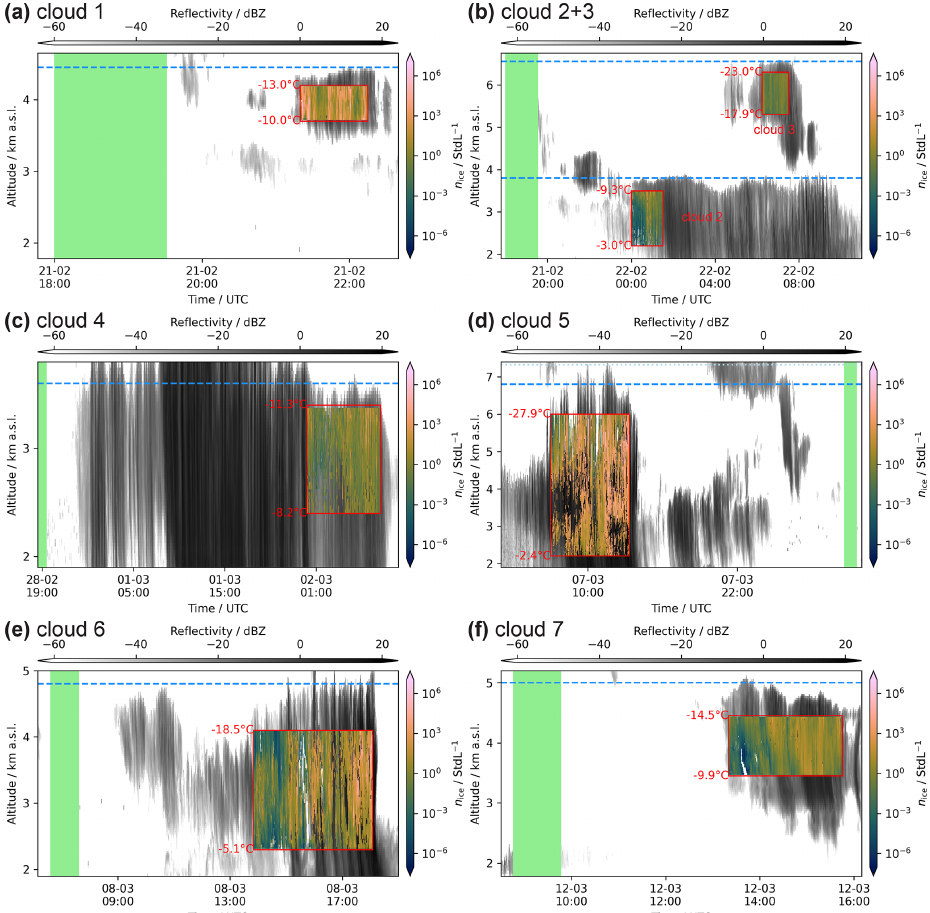
Figure B1. As in Fig. 9a for each panel except for the parameter labeling of h d , t d , and n INP , ct . The green shading indicates the period during which the INP concentration at cloud top (dashed blue line) was retrieved. Calculated and retrieved parameters for each cloud are presented in Table D1. The blue dotted line in (d) indicates the height above which homogeneous freezing is possible ( T < − 38 ◦ C).